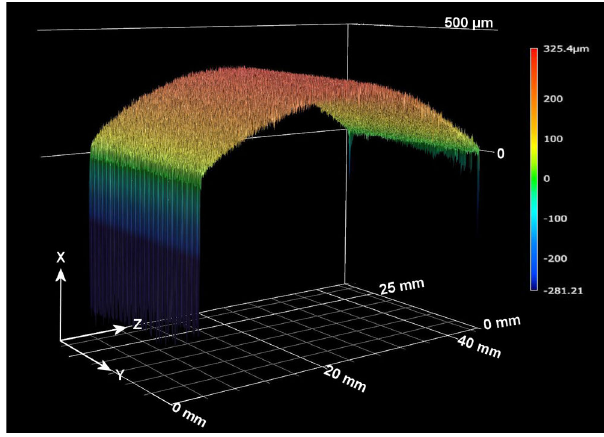
FIG. 13. An anamorphic view of the collimator surface show- ing curvature and roughness for the aluminum test piece used in May 2019.